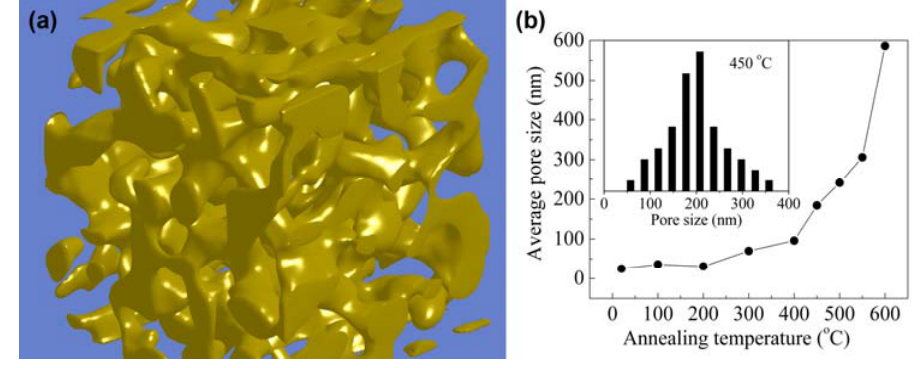
Figure 2. (a) Focused ion beam nanotomography image showing the 3D-structure of bulk nanoporous Au (in collaboration with L. Holzer, Ph. Gasser and B. Münch from EMPA, Switzerland). The ligament size is ~30 nm. (b) Dependence of the average pore width on annealing temperature (Argon atmosphere, 2h). The inset shows the distribution of pore widths after annealing at 450 °C.